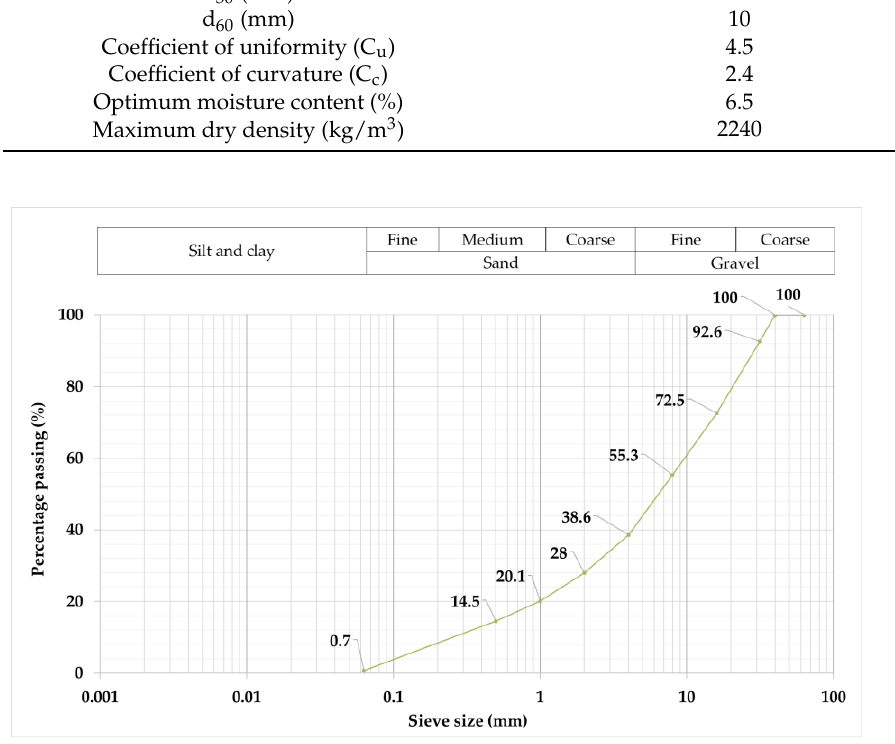
Figure 5. Grain size distribution of soil sample.